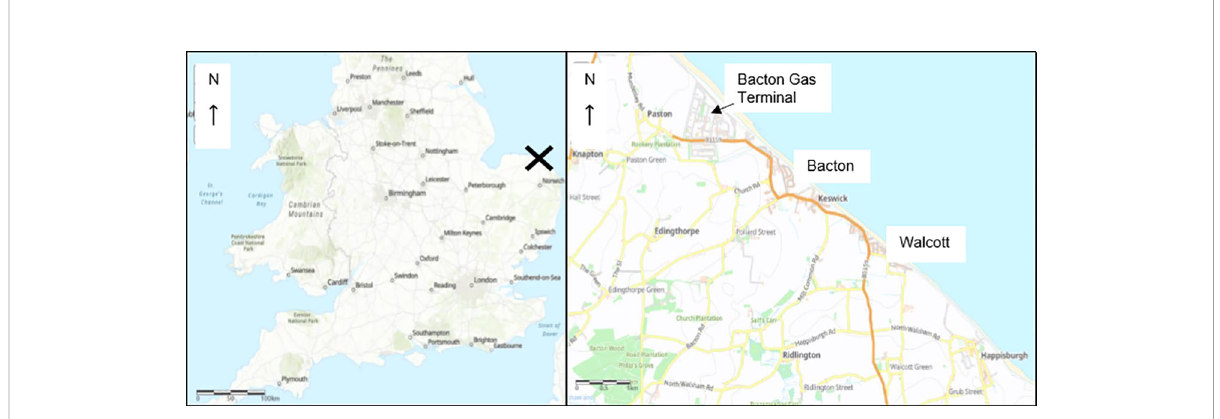
FIGURE 1 Location of the Bacton-Walcott sandscaping scheme on the English coast (left-hand map) (Esri UK, Esri, HERE, Garmin, FAO, NOAA, USGS). The right-hand map indicates the local villages where this study was undertaken (Bacton and Walcott), with respect to Bacton Gas Terminal, where the majority of sediment was placed (© Esri Ordinance